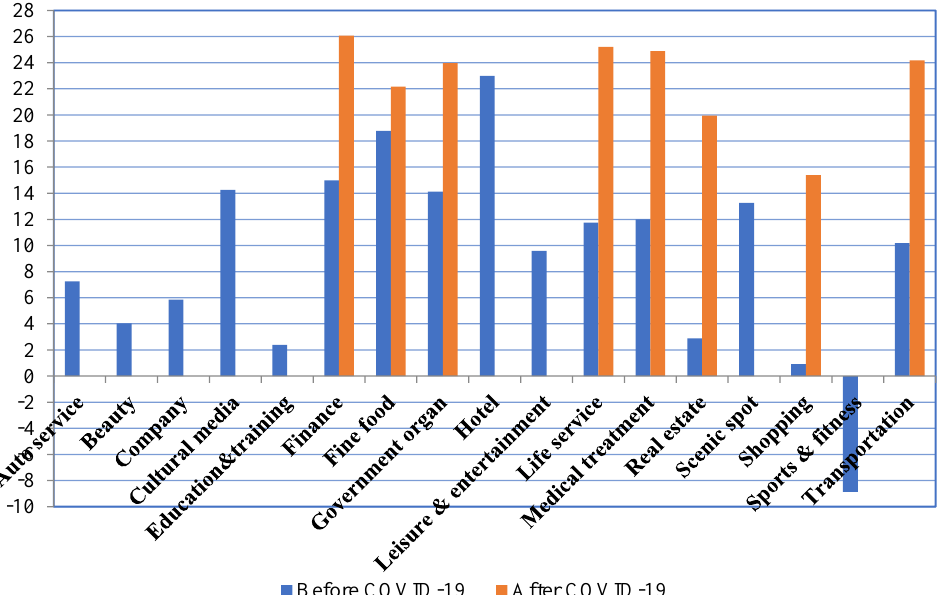
Figure 8. Mean weighted degree of the primary categories before and under the lockdown of COVID-19.